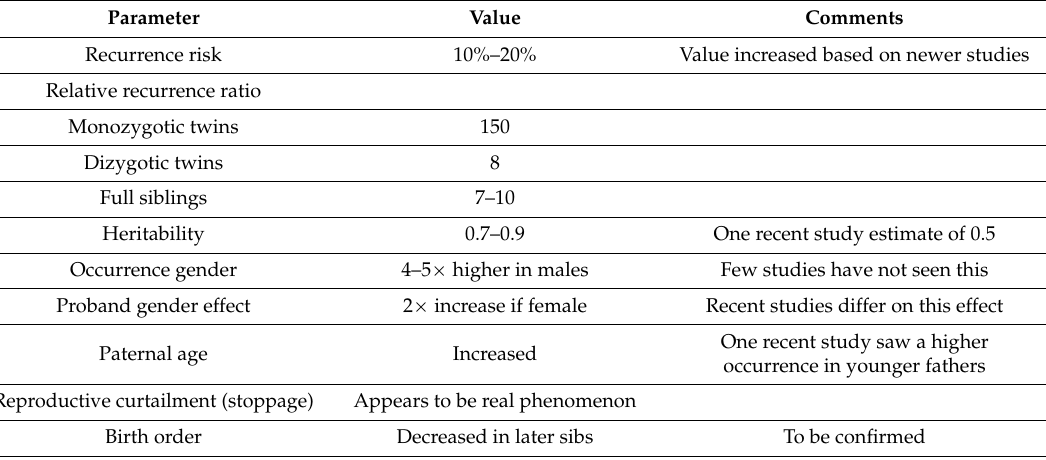
Table 1. Summarizes the current parameters of the population aspects of